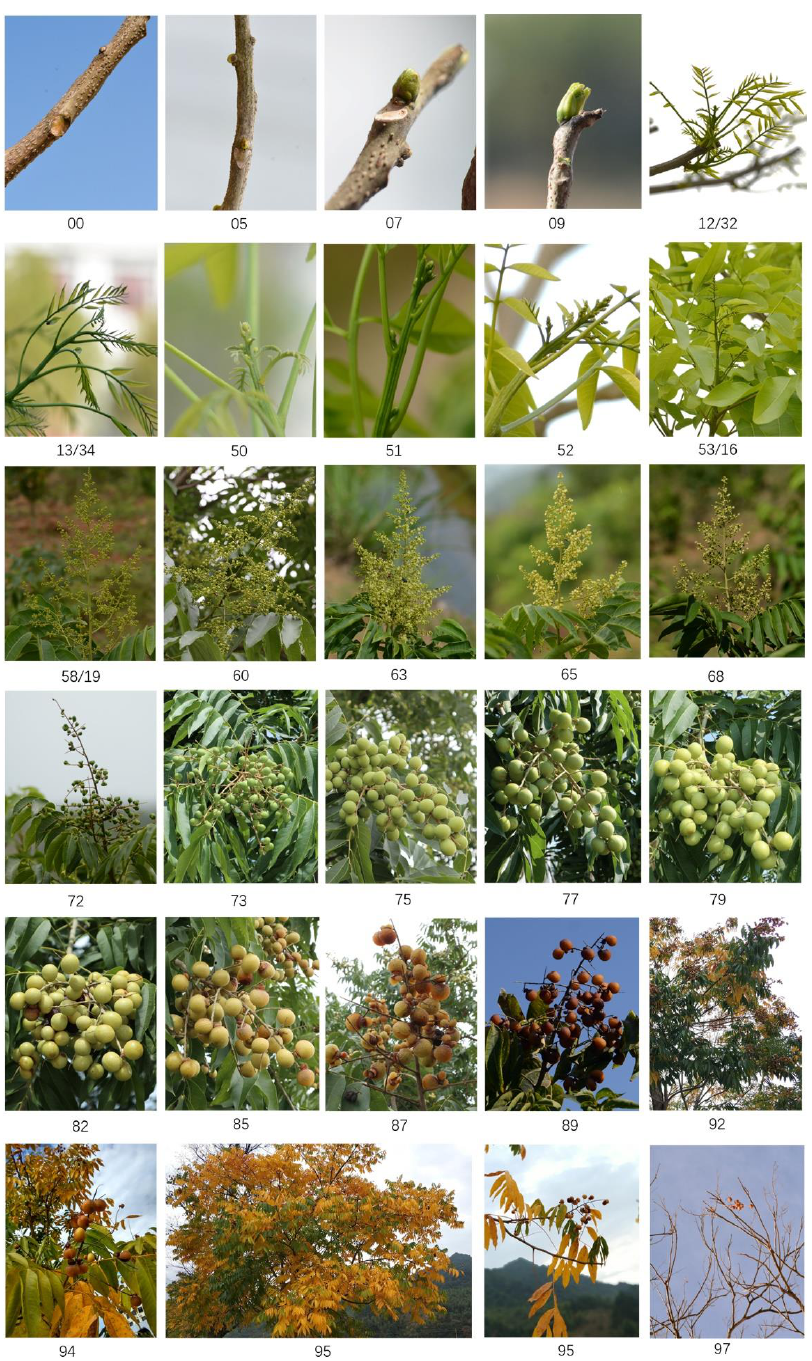
Figure 2. Phenological growth stages of S . mukorossi according to the BBCH scale.